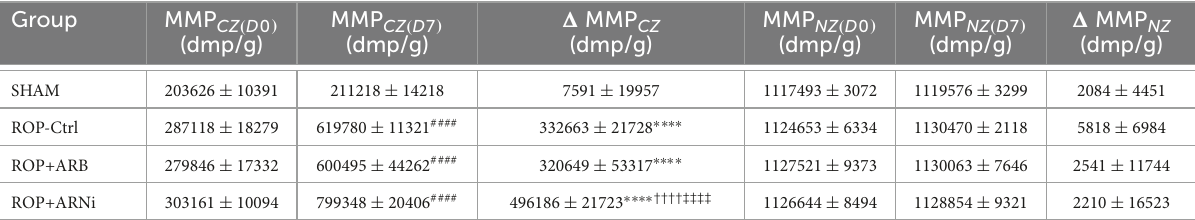
TABLE 2 Measurement of the coronary collateral